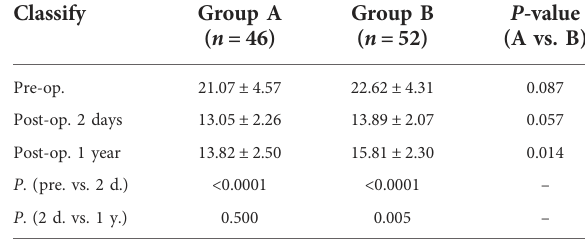
TABLE 2 Anterior height of diseased vertebrae (mean±SD; mm).